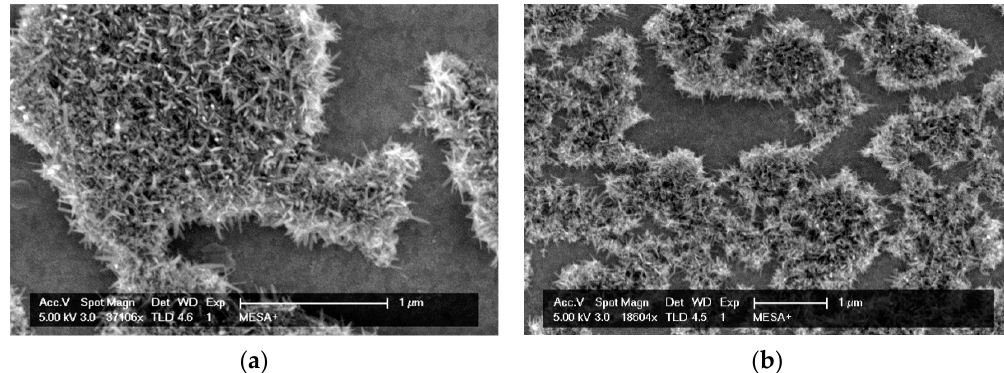
Figure 2. ( a , b ) SEM images of typical resulting RuOx nanorods. The nanorods grew on the precursor islands, with typical width between 15–25 nm and length between 110–150 nm.